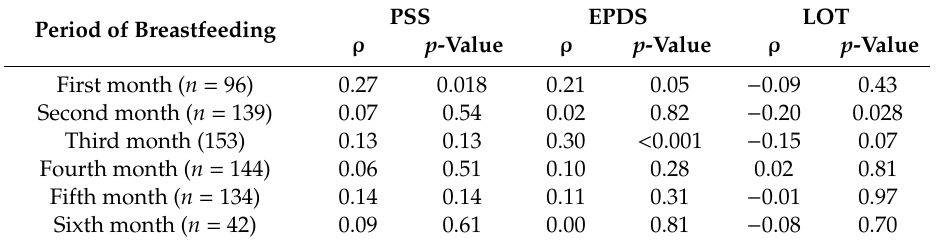
Table 2. Correlations between breastfeeding adherence score and psychological factors stratified by the breastfeeding period. PSS Period of breastfeeding